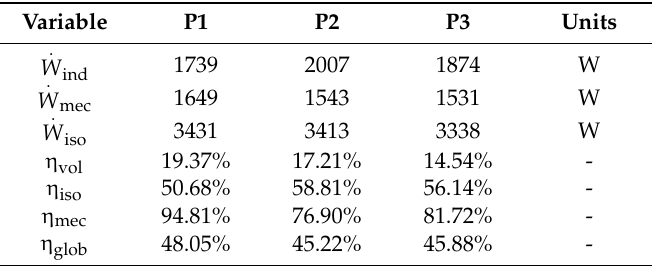
Table 6. Experimental efficiencies of the swash-plate